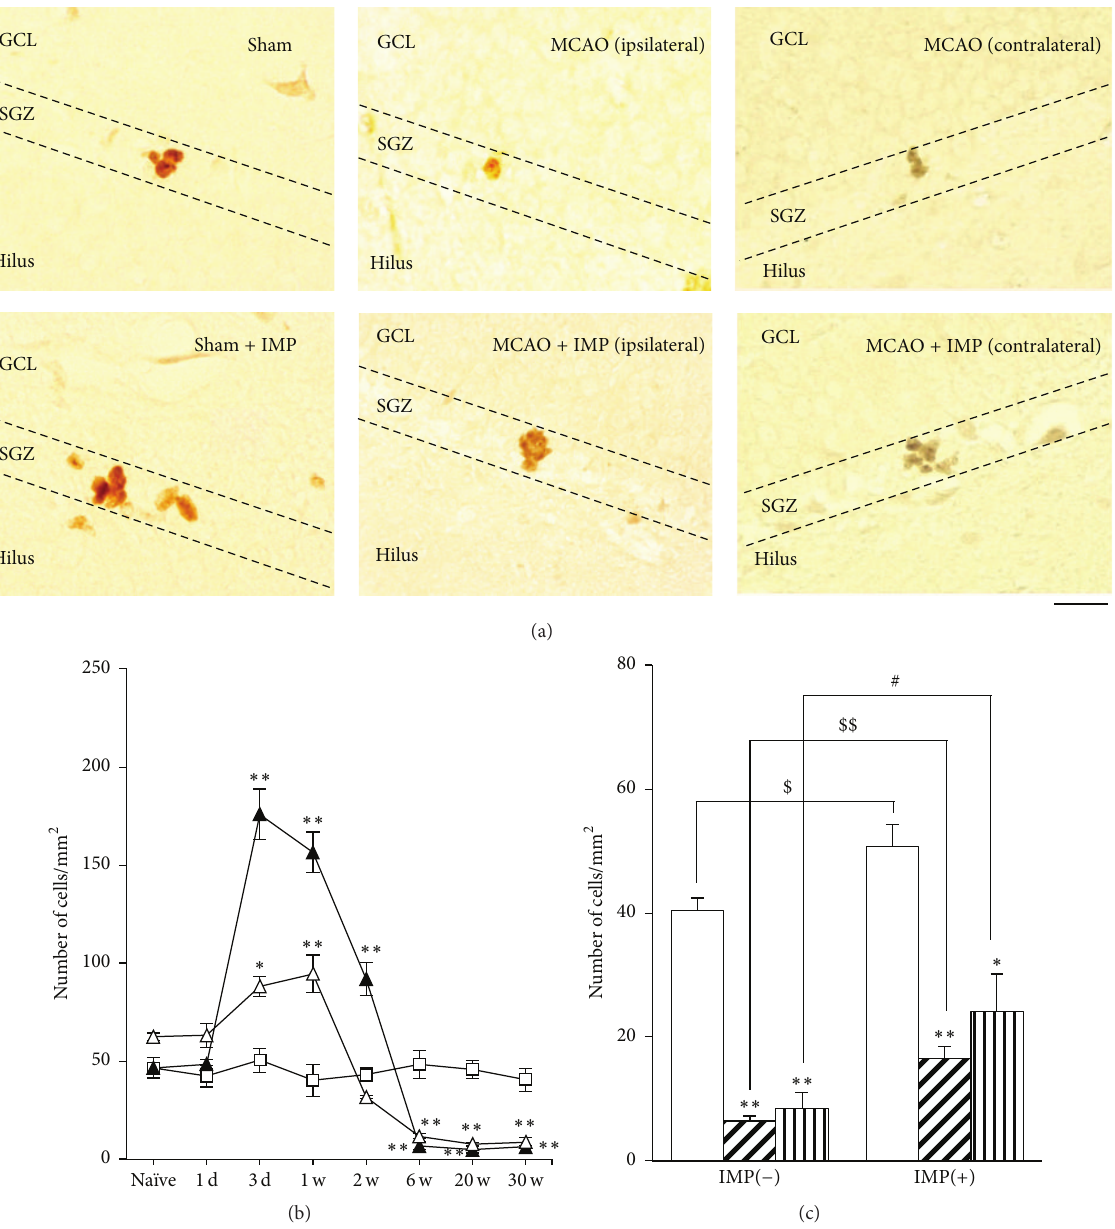
Figure 12: Analysis of Ki67 immunopositive cells in GCL. (a) Typical images of the slices taken at 30 weeks after MCAO. Scale bar indicates 20 𝜇 m. (b) Time course changes of Ki67 immunopositive cells after MCAO in GCL. Symbols used are as follows: open square, sham; closed triangle, ipsilateral MCAO; open triangle, contralateral MCAO. Statistical significance was evaluated with two-way ANOVA followed by = 101.1 ; 𝐹 = 38.2 ; 𝐹 = 37.7 ; ∗∗ 𝑃 < 0.01 versus sham). (c) Analysis of Tukey-Kramer test at each time point ( 𝐹 ( ( group )2 ( time ∗ group )14,96 time )7 the effect of imipramine (IMP) on the number of Ki67 immunopositive cells at 30 weeks after MCAO. Vehicle [IMP( − )] or 20mg/kg/day of IMP for 29 weeks [IMP(+)] from 1 week after the surgical operation was administered. Statistical significance was evaluated with one-way ANOVA followed by Tukey-Kramer test ( 𝐹 5,24 = 29.53 ; ∗ 𝑃 < 0.05 and ∗∗ 𝑃 < 0.01 versus sham [IMP( − )]; # 𝑃 < 0.05 versus contralateral MCAO [IMP( − )]; 𝑁 = 5 /group). Unpaired 𝑡 -test was performed with sham [IMP( − )] versus [IMP(+)] ( 𝑡 = −2.53 , $ 𝑃 < 0.05 ) or with ipsilateral MCAO [IMP( − )] versus [IMP(+)] ( 𝑡 = −4.74 , $$ 𝑃 < 0.01 ).